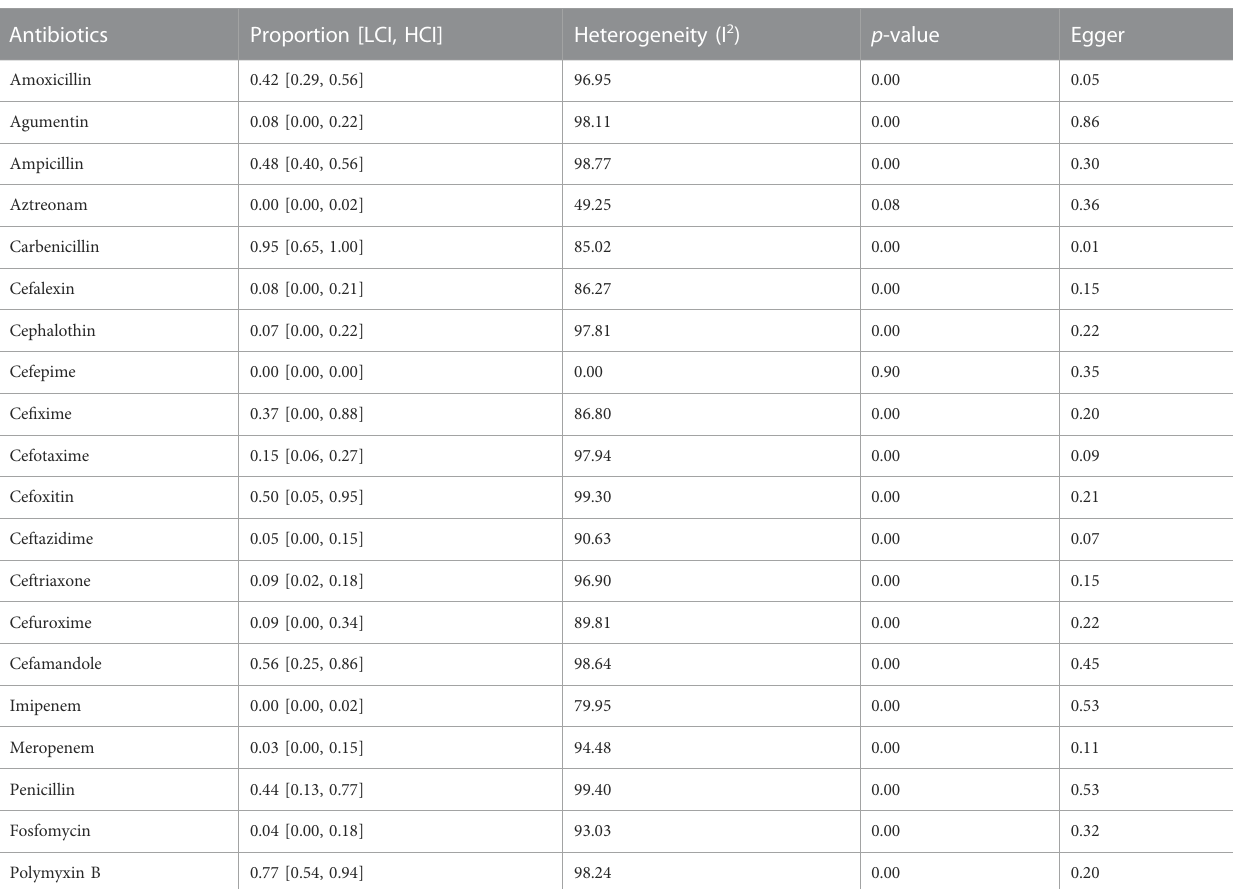
TABLE 2 Proportion of Vibrio cholera antibiotic-resistant